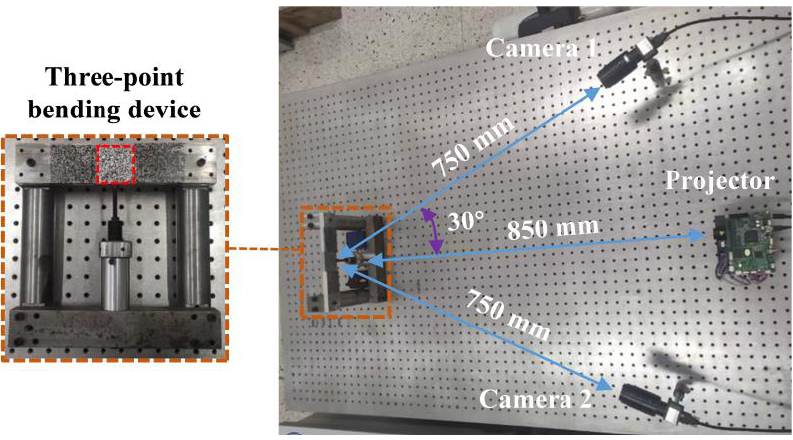
Figure 10. Experimental setup.